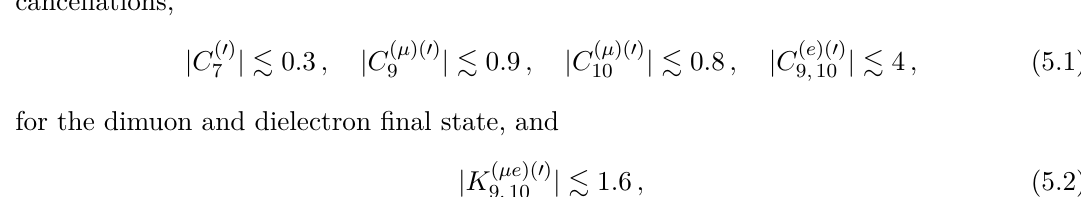
in the full q 2 -region (left 10